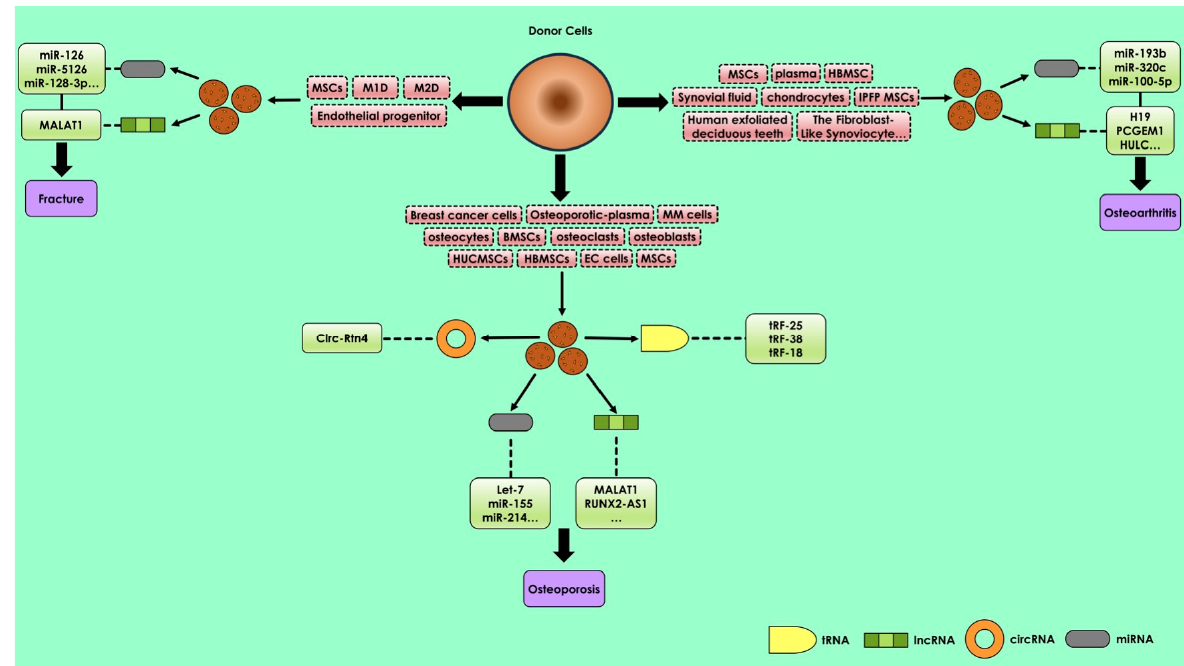
Figure 4. Regulatory action of various exosomal ncRNAs including lncRNA, miRNA, circRNA, and tRNA in osteoporosis, osteoarthritis, and bone fracture repairing. The expression of exosomal ncRNA may potentially modulate bone diseases. The major source cells that contribute exosomes, which participate in osteoporosis, are BMSCs, HUCMSCs, hBMSCs, MSCs, osteocytes, osteoclasts, osteoblasts, and osteoporotic plasma; in osteoarthritis are hBMSCs, MSCs, plasma, chondrocytes, and synovial fl uids; and in bone fracture repairing are MSCs, M1D, M2D, and endothelial progeni- tors.